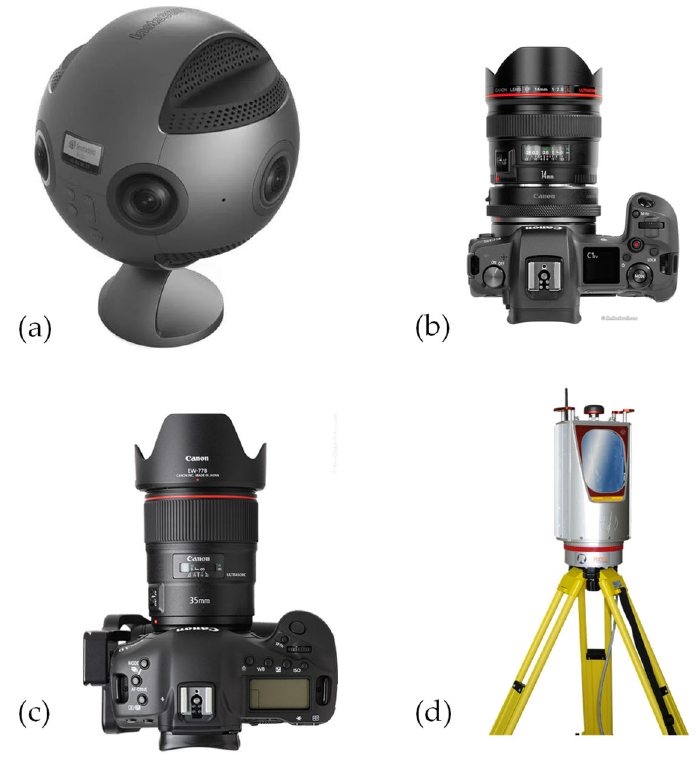
Figure 3. Hardware used in this study: ( a ) Insta360 Pro with 6 fisheye lenses, ( b ) Canon EOS RP mirrorless DSLR with 14 mm lens to capture the reference DSLR model, ( c ) Canon 5Ds R DSLR with 35 mm lens to capture the High ‐ Quality images for the improved 360 + HQ model, and ( d ) Riegl VZ ‐ 400i terrestrial laser scanner.